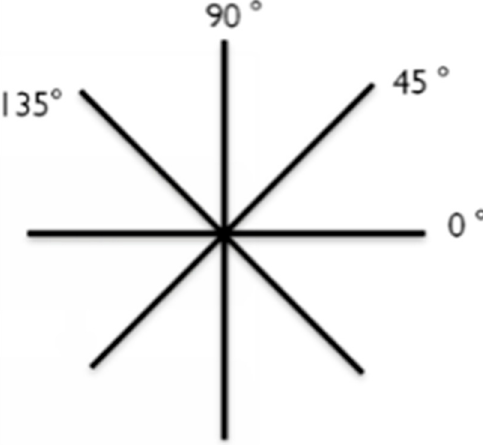
Figure 8 . Four directions of convolution filtering. Figure 7 . Four directions of convolution filtering. Figure 8. Four directions of convolution